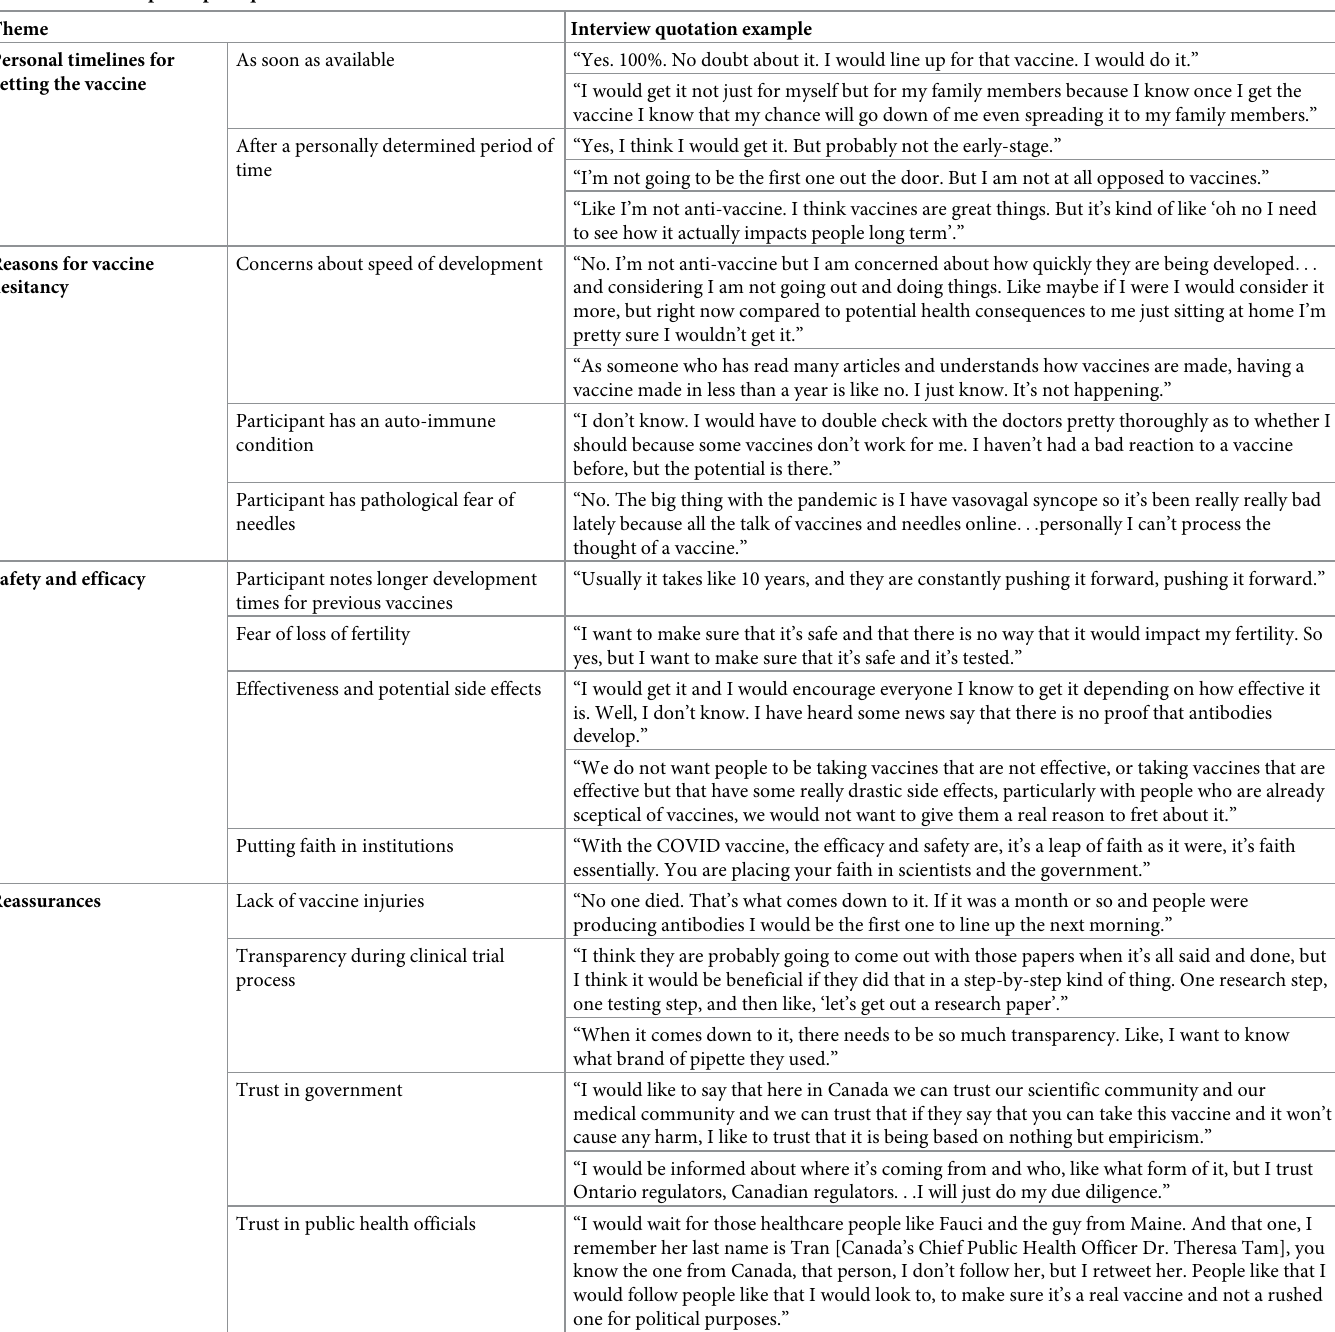
Table 7. Interview participant